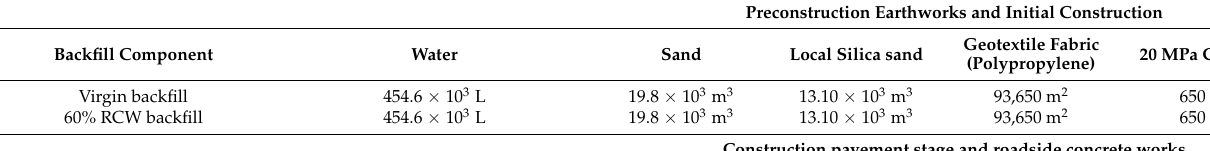
Table 1. Lifecycle inventory for the different pavement section alternatives considered in this study 1